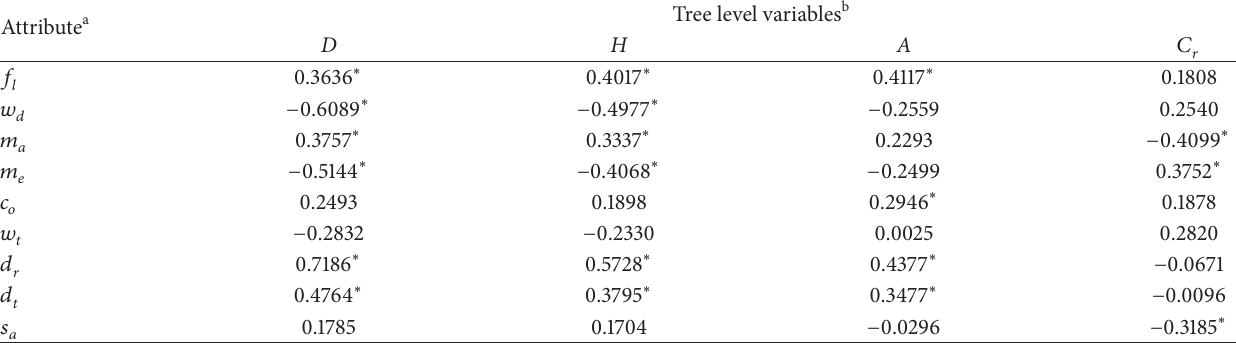
Table 5: Bivariate linear association between tree level variables and fibre attribute values at midrotation as measured by the Pearson product moment correlation